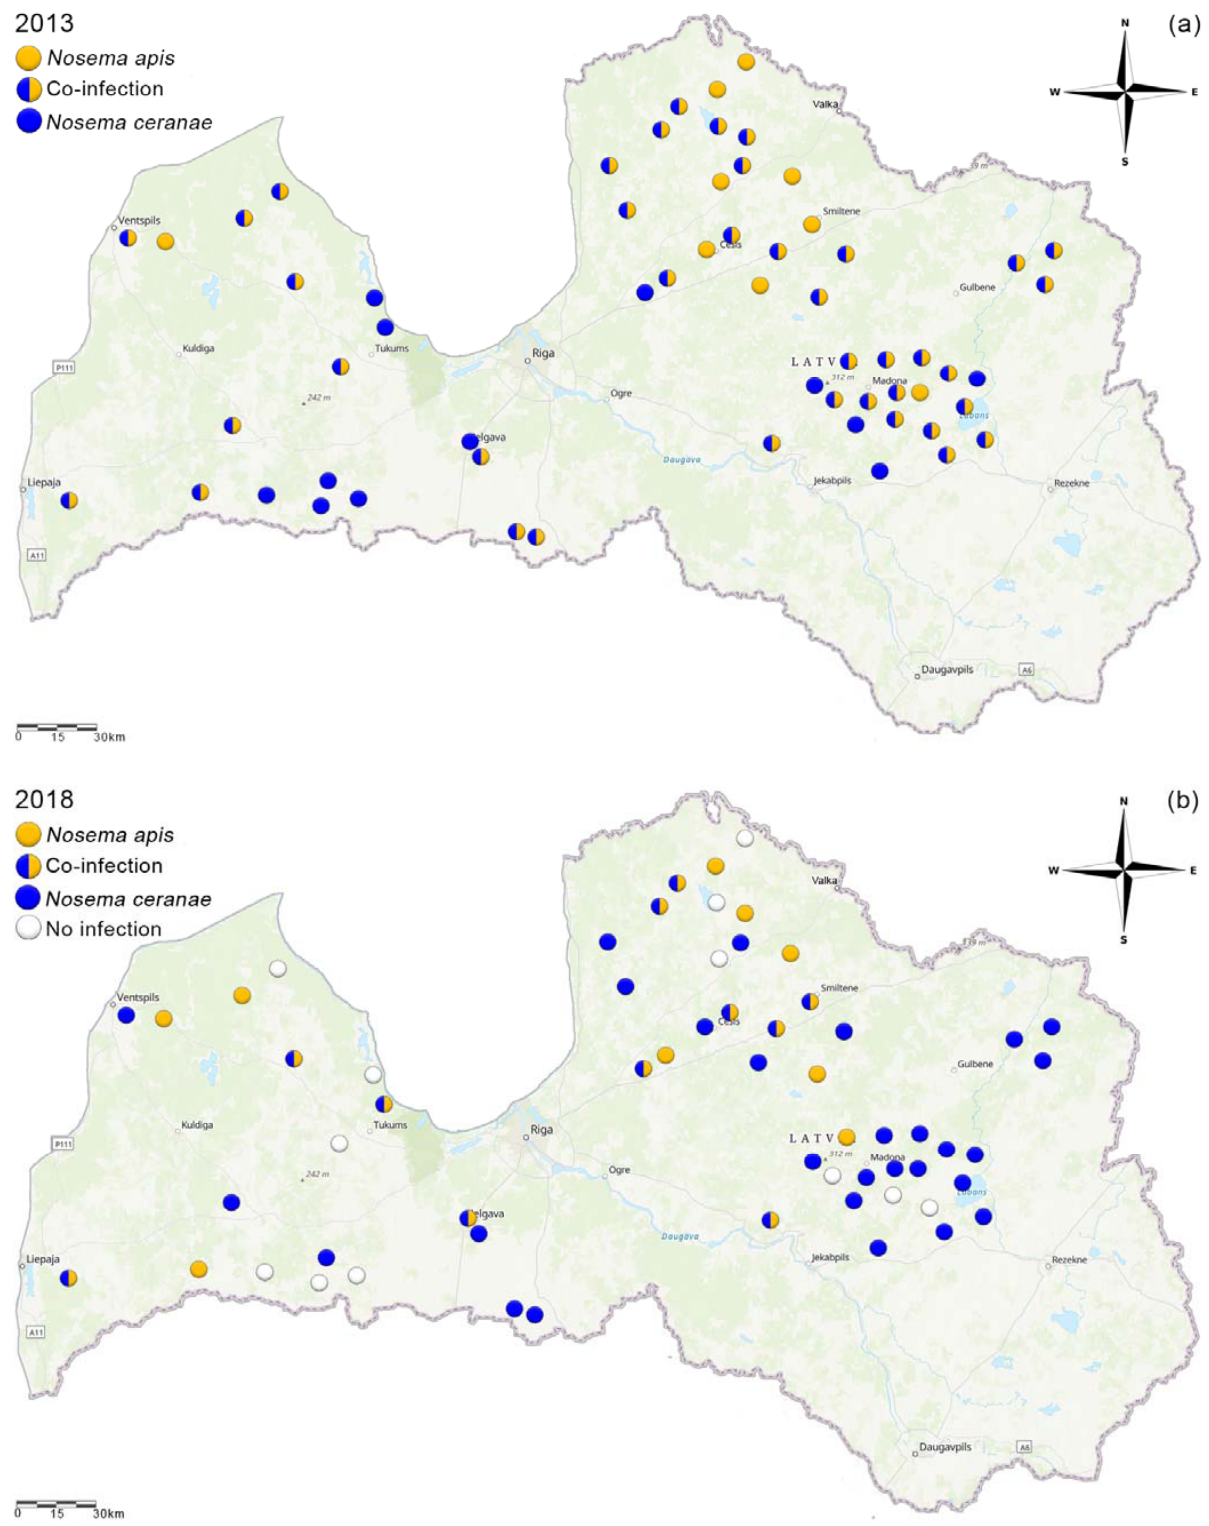
Figure 3. Nosema species prevalence in Latvia in 2013 (May) ( a ) and 2018 (May) ( b ) (ArcGis online).